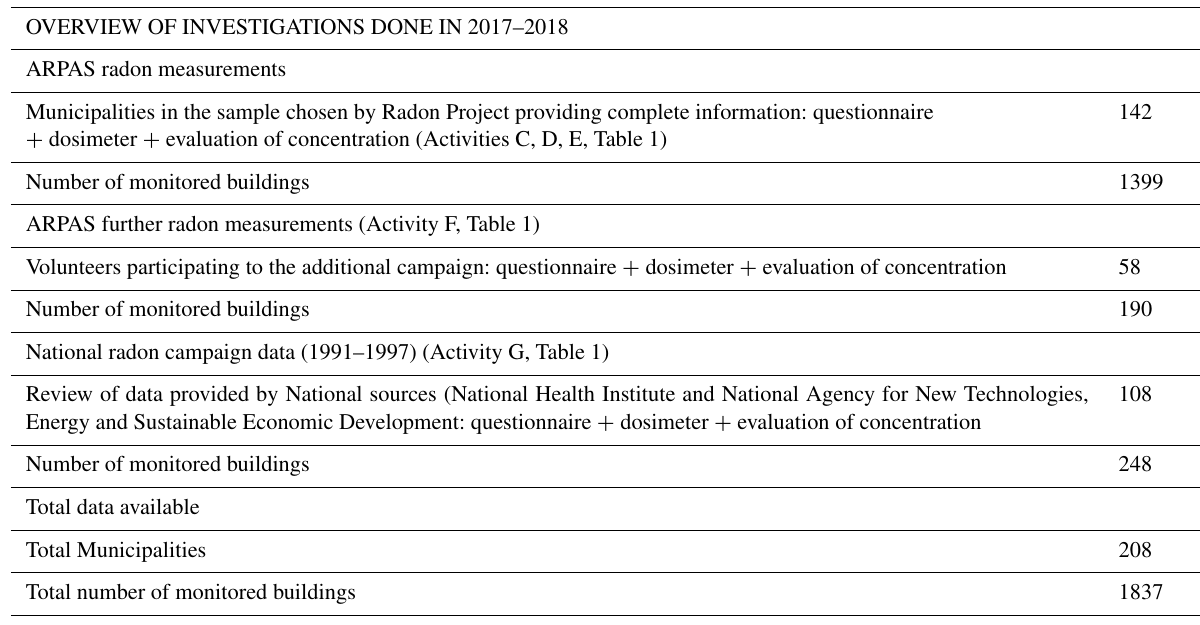
Table 2. Panel summary of radon measurements gathered during the Sardinia Regional Agency for Environmental Protection Radon Project. OVERVIEW OF INVESTIGATIONS DONE IN 2017–2018